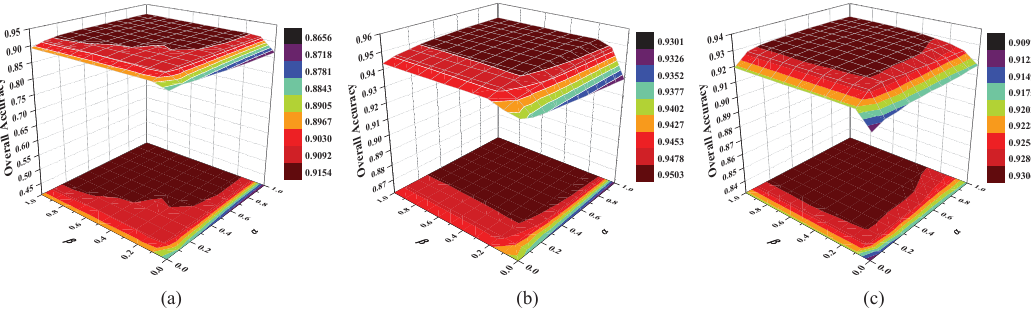
Figure 6. OAs with different tradeoff parameters α and β . ( a ) PaviaU. ( b ) Heihe. ( c ) Washington DC Mall.